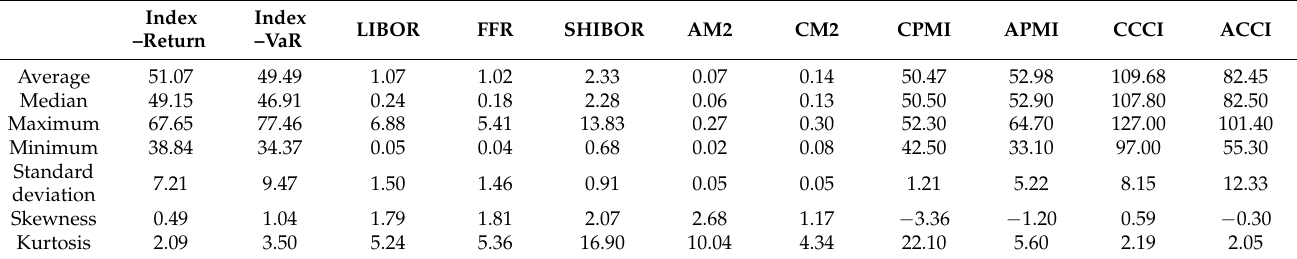
Table 5. Descriptive statistics of the related